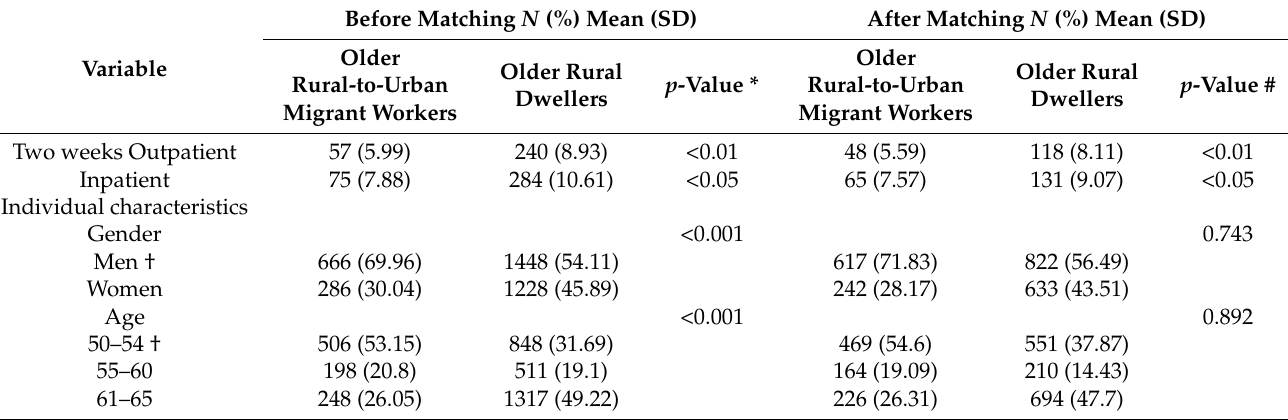
Table 1. Descriptive statistics of independent variables before and after